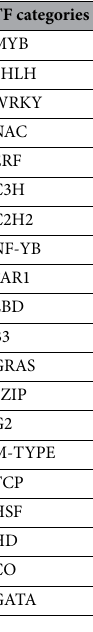
Table 3. List of the first twenty TFs identified in the DEGs.